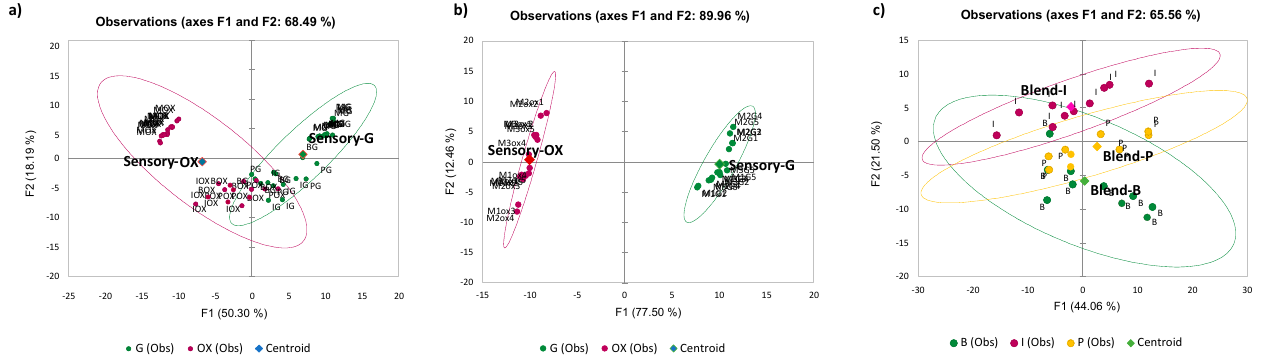
b) Observations (axes F1 and F2: 89.96 %) Observations(axesF1 and F2: 65.56 %)